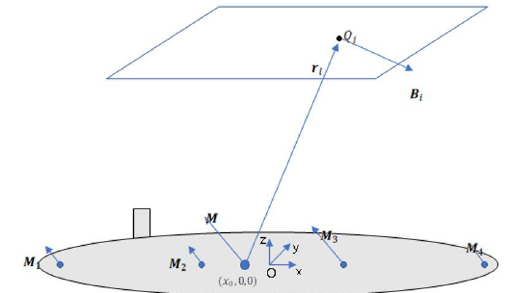
Figure 10. Schematic diagram of the relationship between the submarine’s near- and far-field magnetic dipole model and measurement